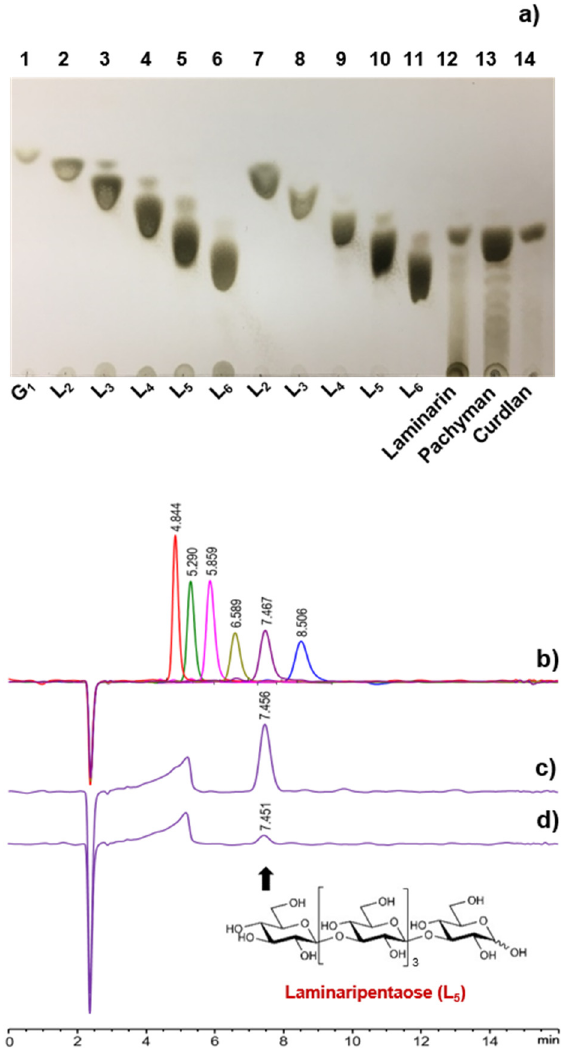
Figure 5. TLC and HPLC analyses of degradation products of D -laminarioligosaccharides (L 2 –L 6 ) and β -1,3- D -glucans by rGluY: ( a ) Lanes 1 to 6, standard markers ( D -glucose, G 1 ; D -laminaribiose, L 2 ; D -laminaritriose, L 3 ; D -laminaritetraose, L 4 ; D -laminaripentaose, L 5 ; D -laminarihexaose, L 6 ); lanes 7 to 11, reaction of rGluY with D -laminarioligosaccharides (L 2 –L 6 , each 1 mg); lane 12, reaction of rGluY with 1 mg laminarin; lane 13, reaction of rGluY with 1 mg pachyman; lane 14, reaction of rGluY with 1 mg curdlan; ( b ) total ion chromatogram of the standards (G 1 , a peak with a retention time (RT) of 4.844; L 2 , a peak with a RT of 5.290; L 3 , a peak with a RT of 5.859; L 4 , a peak with a RT of 6.589; L 5 , a peak with a RT of 7.467; L 6 , a peak with a RT of 8.506); ( c ) total ion chromatogram of the degradation products of pachyman; ( d ) total ion chromatogram of the degradation products of curdlan.